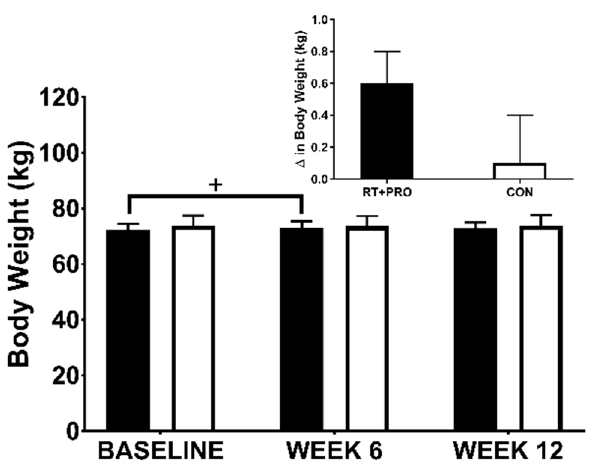
Figure 5. Body weight in CON (white bars; n = 20) and RT + PRO (black bars; n = 19) groups during baseline week 6 and 12. A addition symbol (+) represents differences from baseline to Week 6. The insert graph shows the change from baseline to Week 12. Values are presented as mean ± SE.